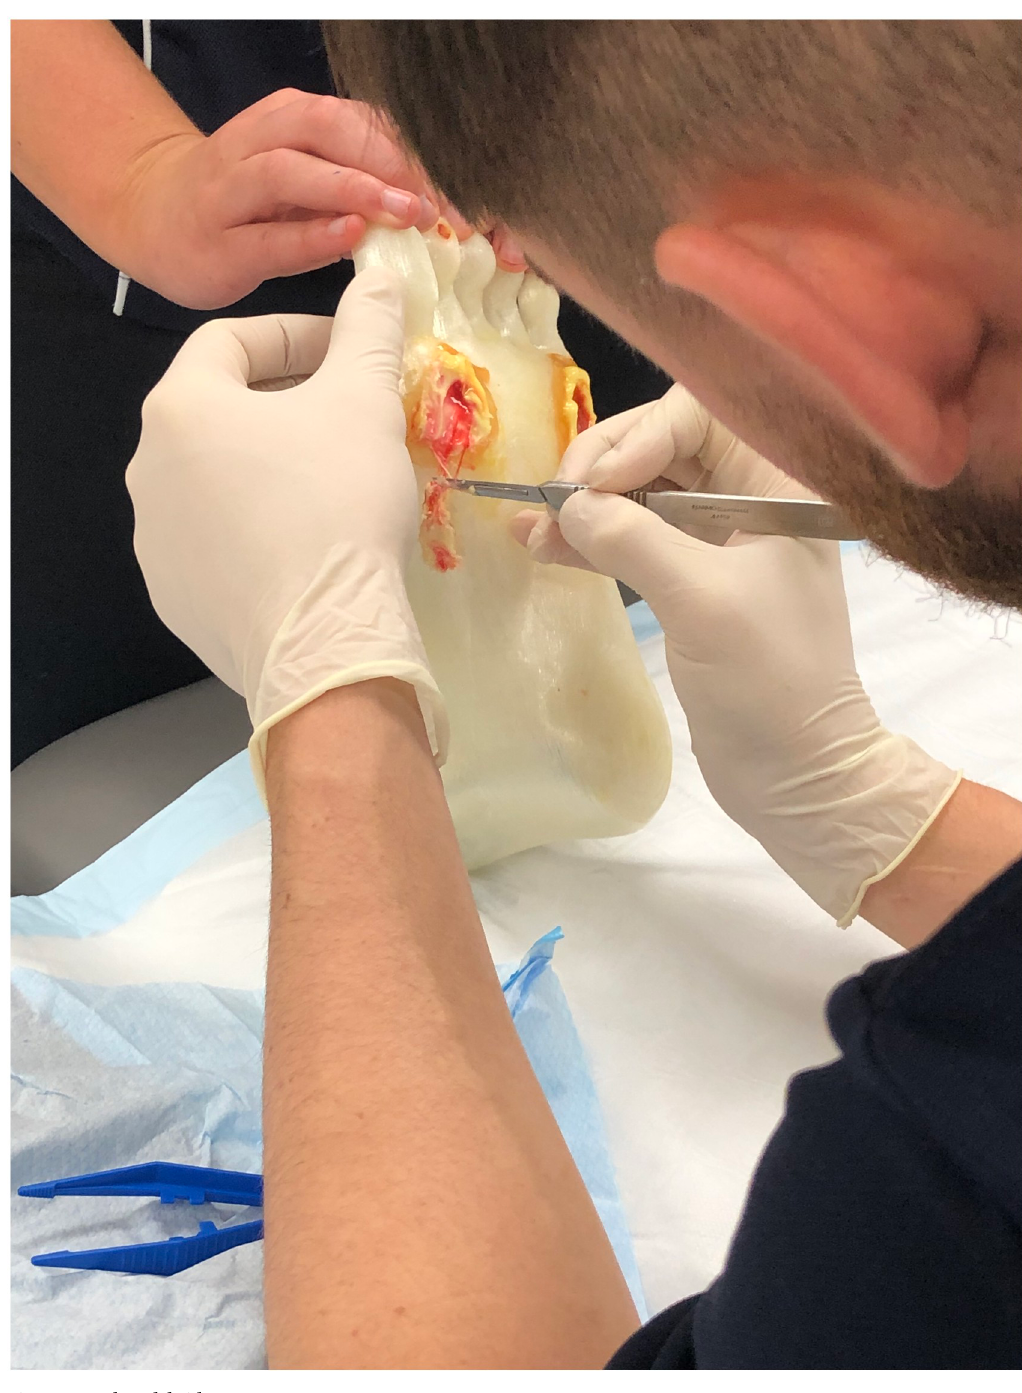
Fig 3. Foot ulcer